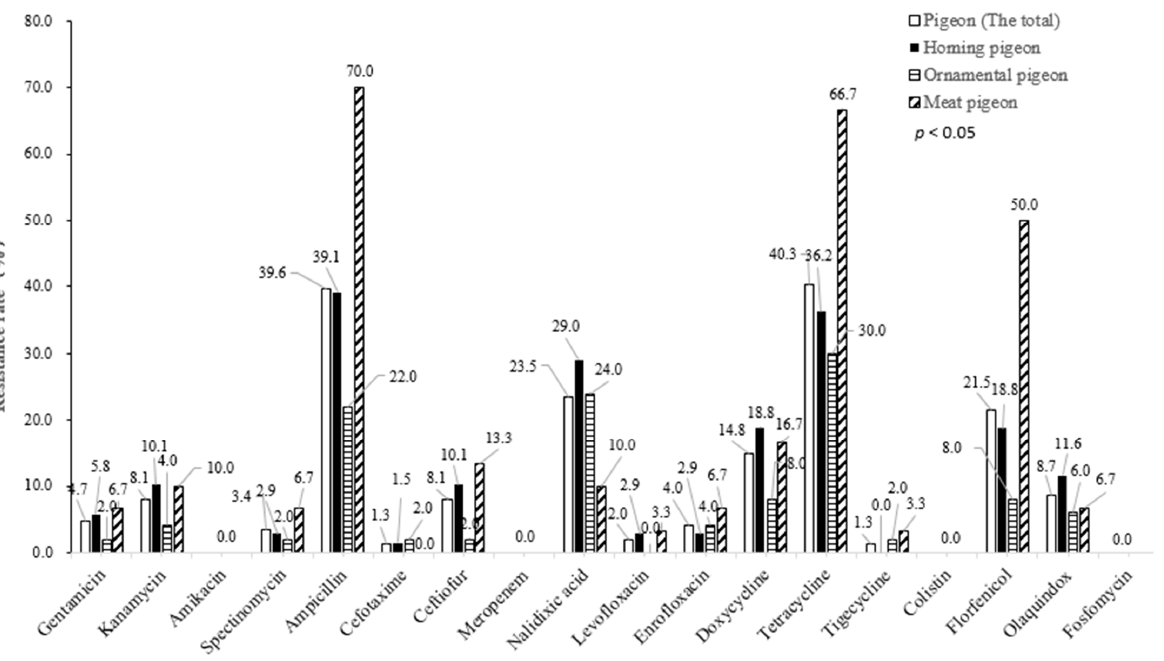
Figure 1. Antimicrobial resistance ( AMR) of Escherichia coli ( E. coli ) isolates from different pigeon species to 18 kinds of antibiotics.